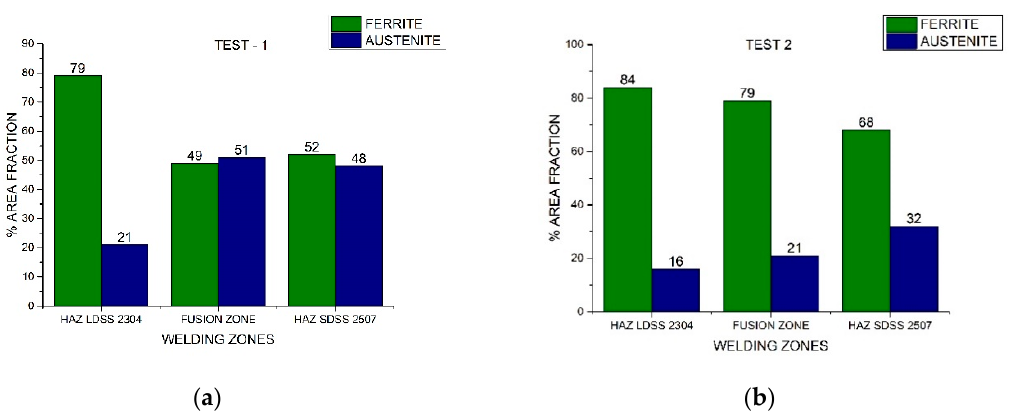
Figure 6. Welded zones by optical microscope to 50 ×: 220 A welding current. Materials 2020 , 13 , x FOR PEER REVIEW